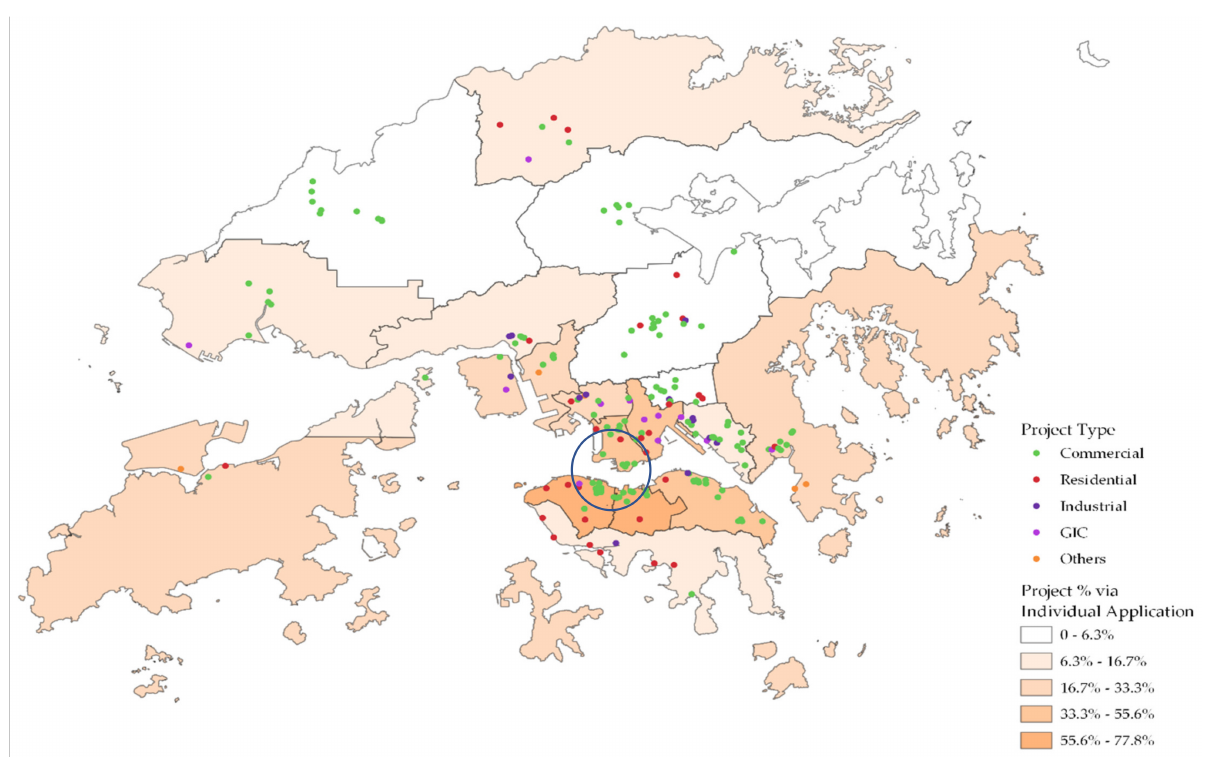
Figure 2. Map showing the project distribution in Hong Kong. Notes: (1) the blue circle indicates the proximate location of Hong Kong’s CBD [53]. (2) Boundaries of districts in the figure follow the delineation adopted in 2016 Population By-census [54]. (3) The map was produced using QGIS